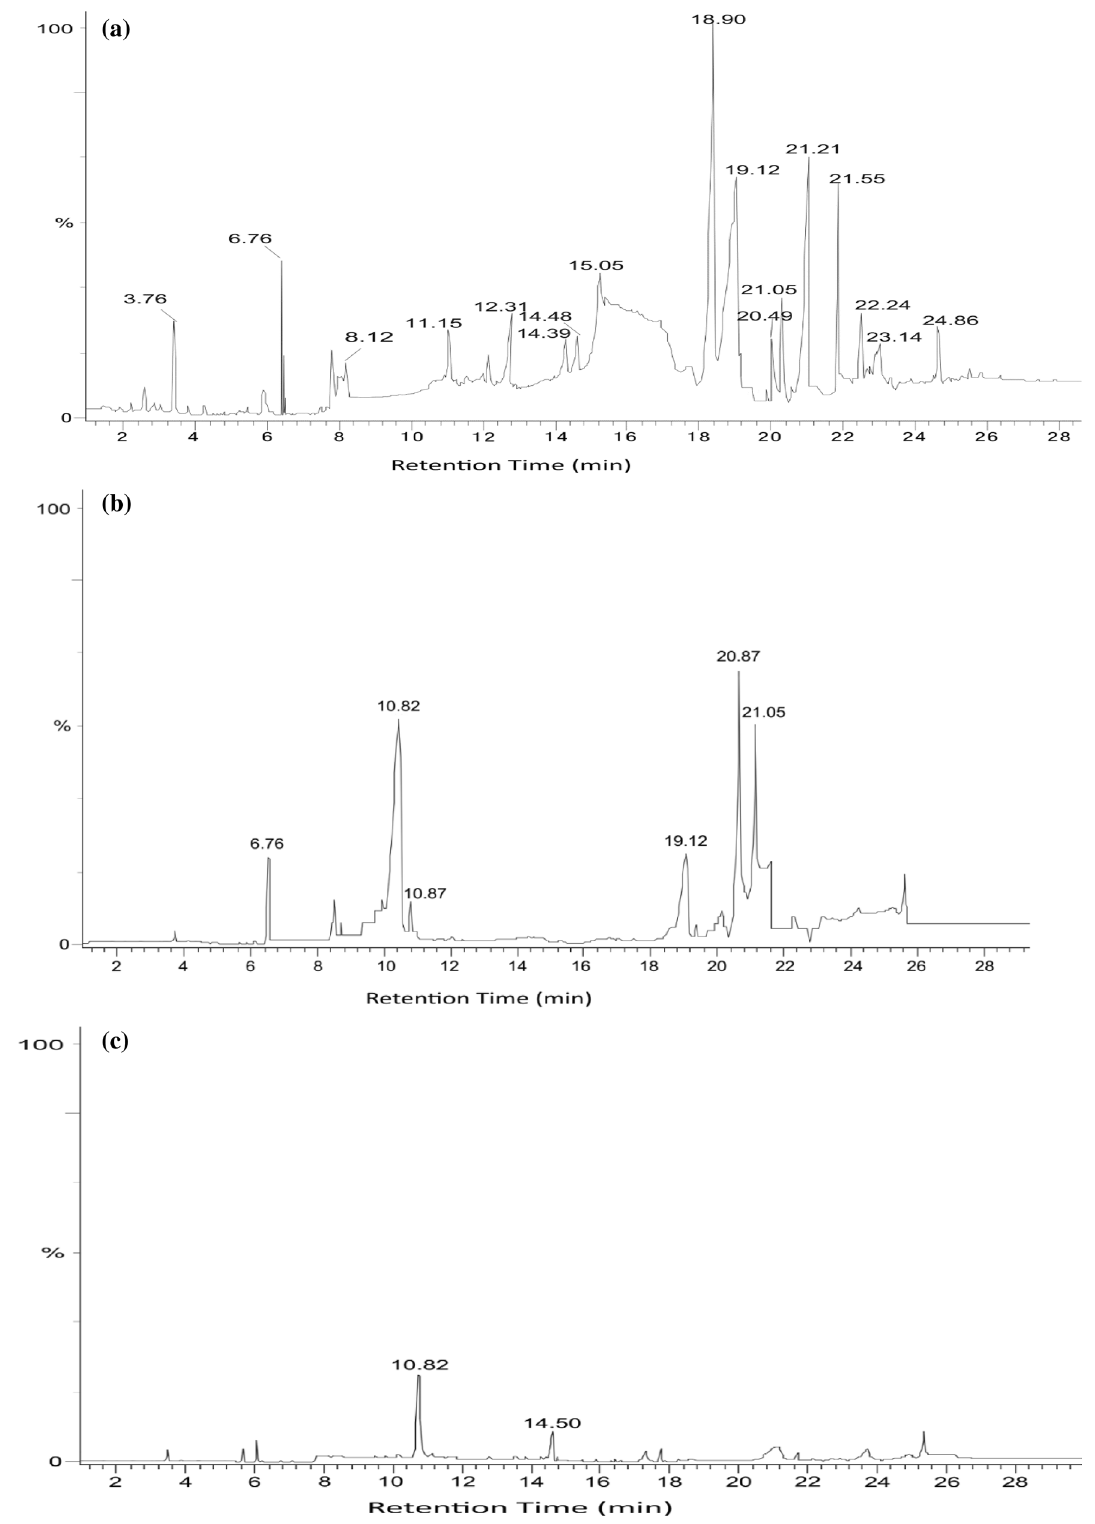
Fig. 6 GC–MS chromatograph of control ( a ); degraded ( b : with axenic culture) and degraded ( c : with mixed culture) samples of kraft